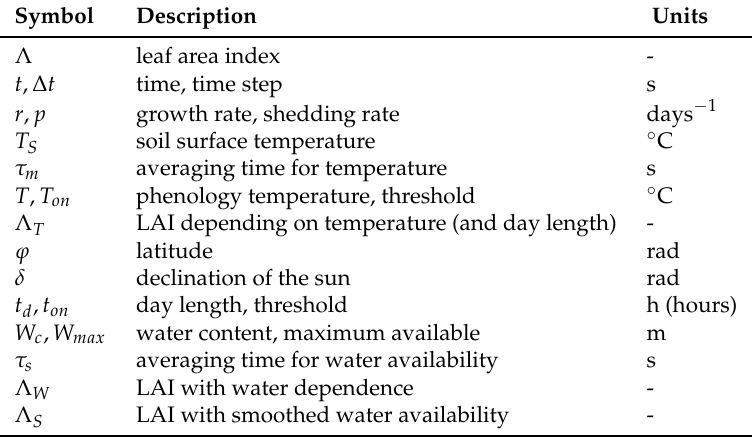
Table 1. Parameters of the newly implemented phenology model based on Knorr et al. (2010)